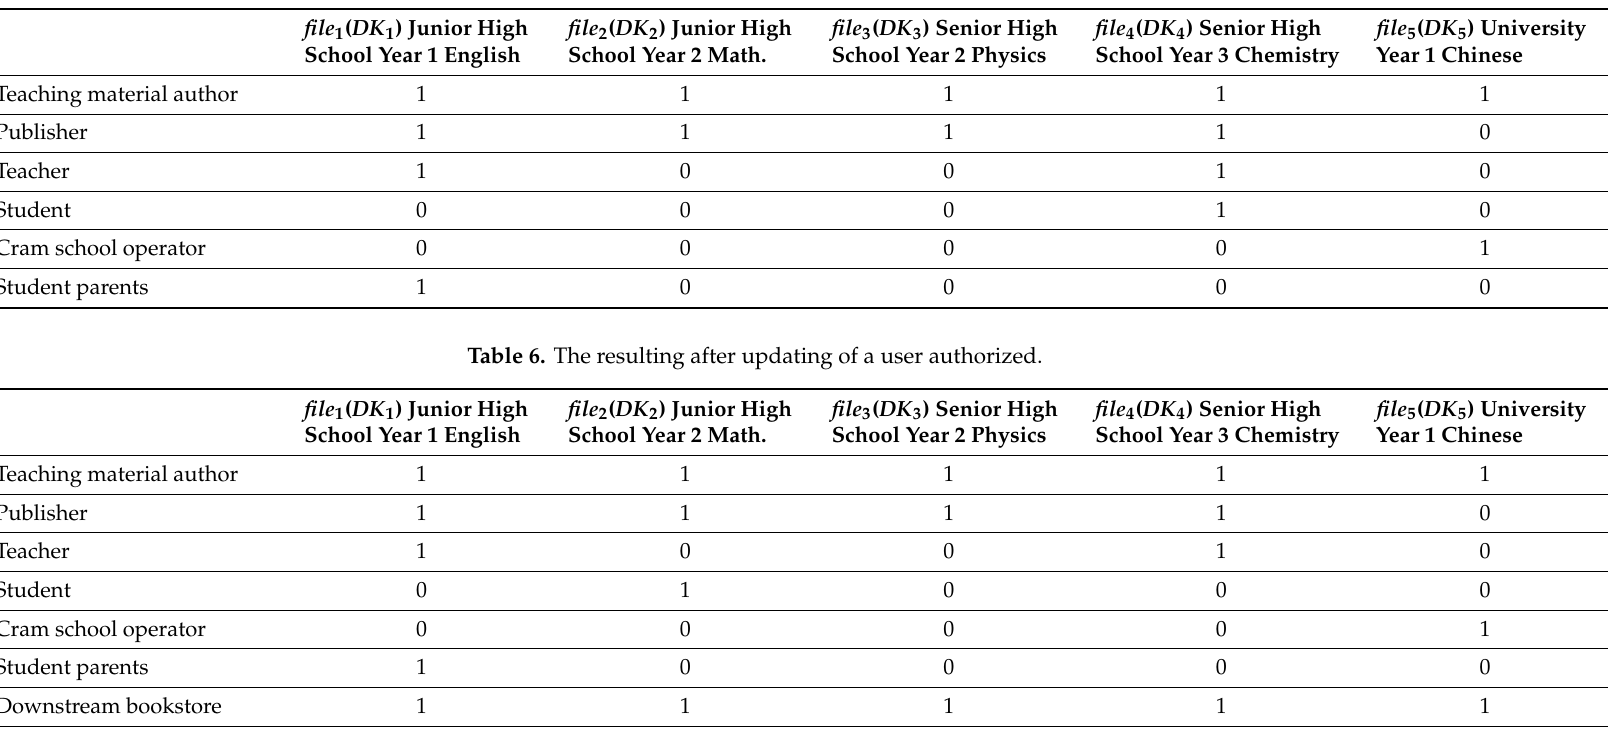
Table 5. The resulting after revoking the existing current security class.